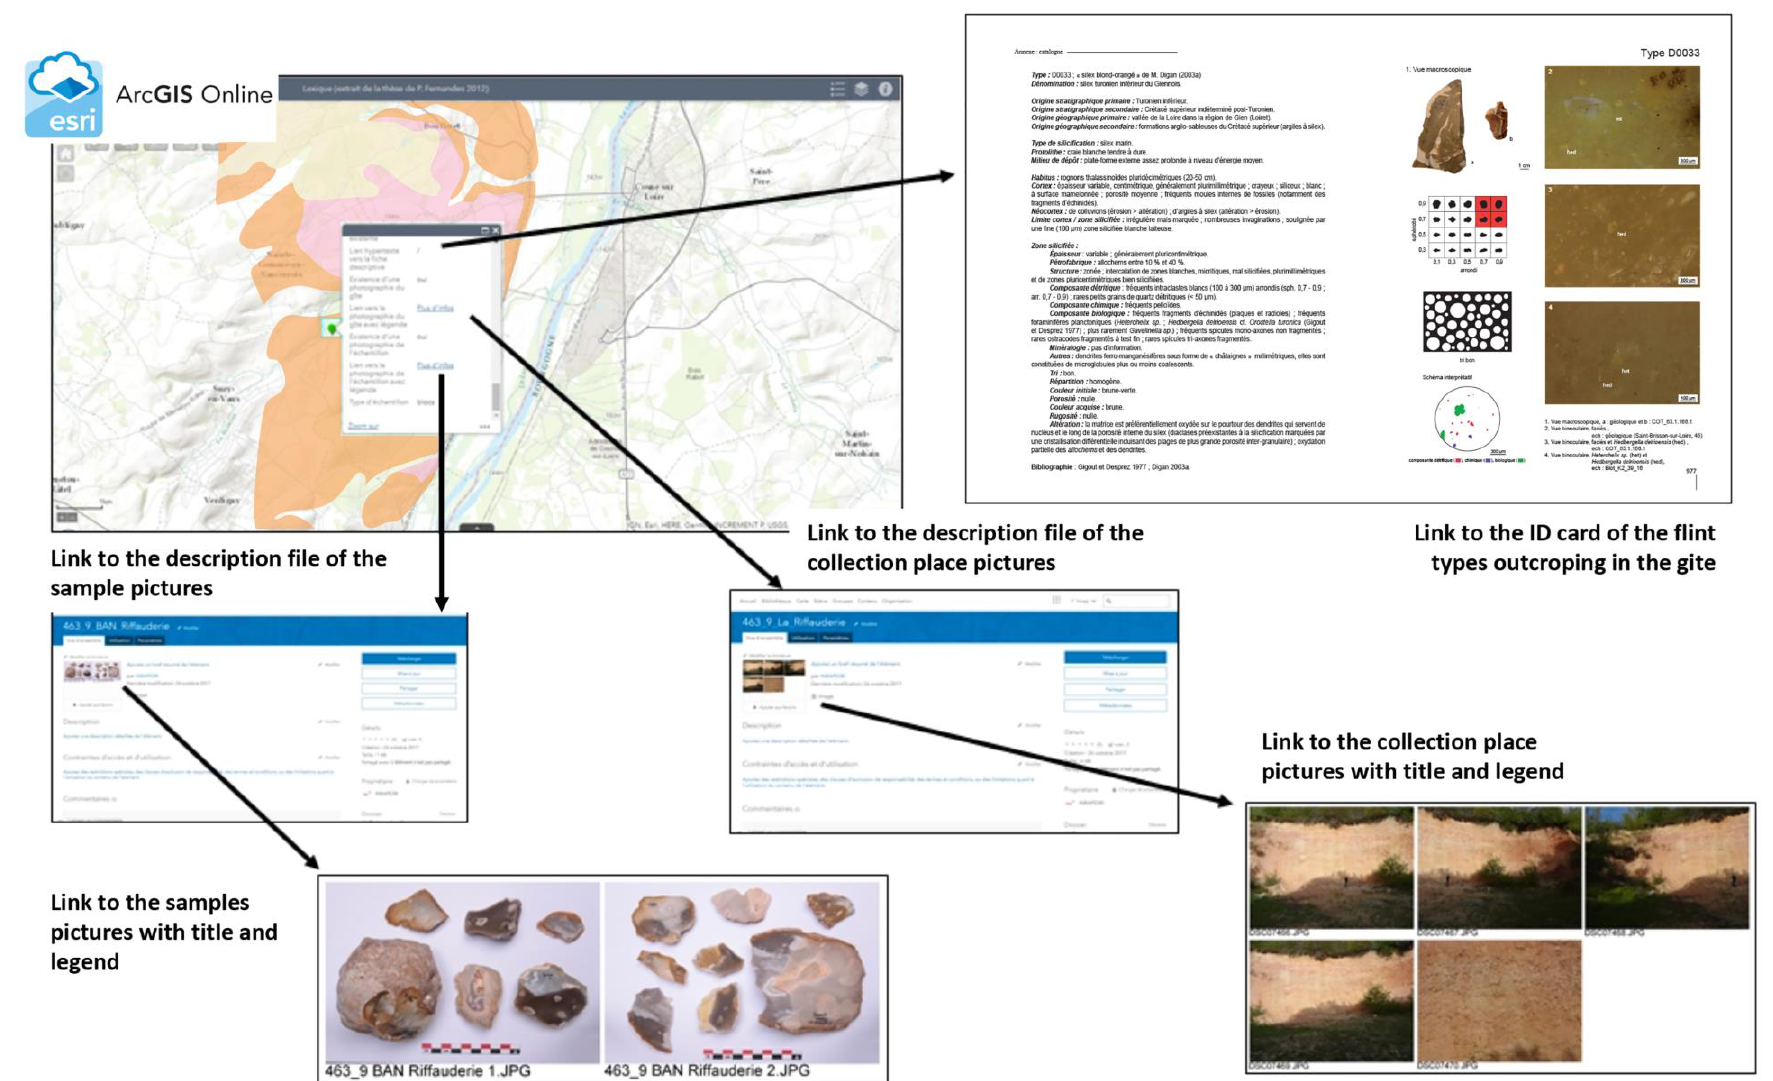
Figure 4. Excerpt from the GIS. Attribute data of the secondary deposit of La Riffauderie at Banay (Cher) and the descriptive card of type D0033 found in this